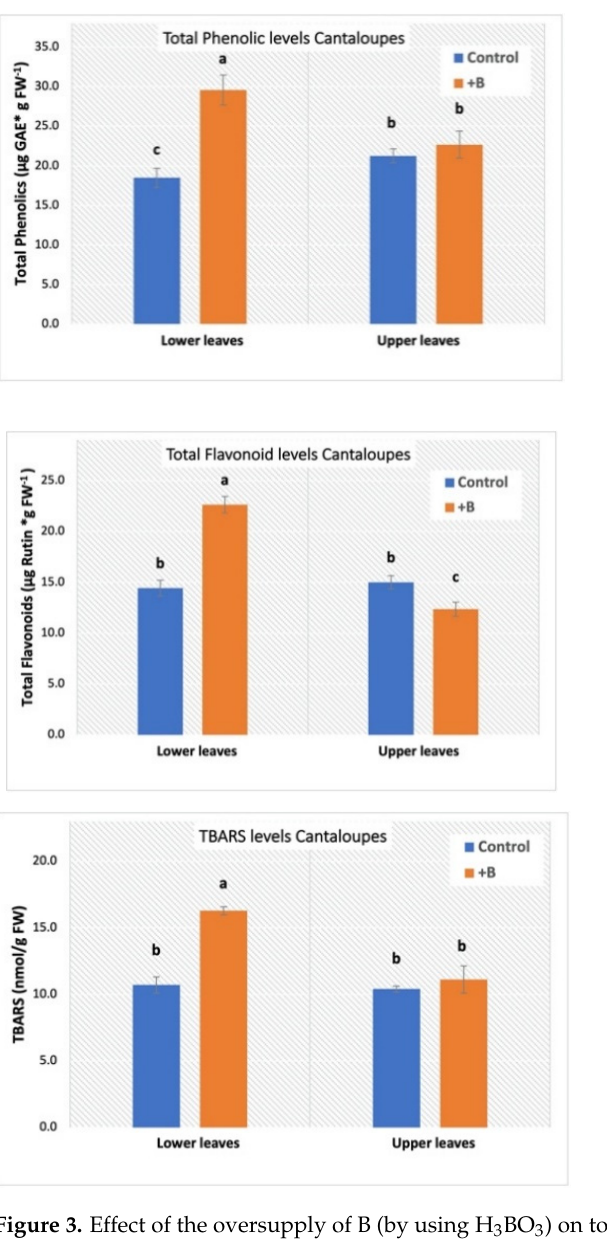
Figure 2. Effect of the oversupply of B (by using H 3 BO 3 ) on the photosynthetic pigment (chlorophyll, carotenoids) content and on RCA1 gene expression of young (close to the apical meristem) and mature (close to the root-to-shoot intersection) leaves of cantaloupes ( C. melo var. Cantalupensis cv. Retato Degli Ortolani) and Armenian cucumbers ( C. melo var. flexuosus cv. Abruzzese Tortarello). Growth period lasted 35 d, where no visible B toxicity symptoms were apparent (Figure 1). Means followed by different letters indicate significant differences ( p = 0.05). Values are the mean of ten replications (± SD).